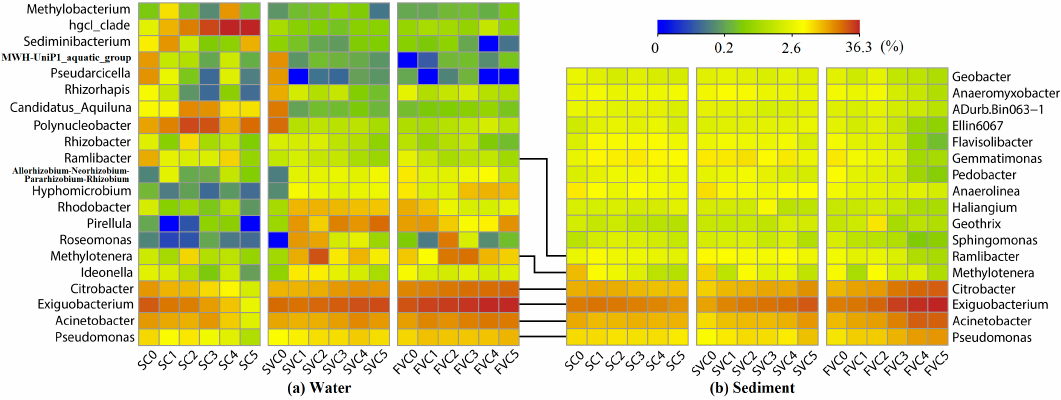
Figure 5. Relative abundance of bacterial reads classified at genus level along the timescale (week 0–5) obtained from Ribosomal Database Project (RDP) classifier analysis (mean relative abundance > 0.5%). ( a ) Water, ( b ) Sediment.